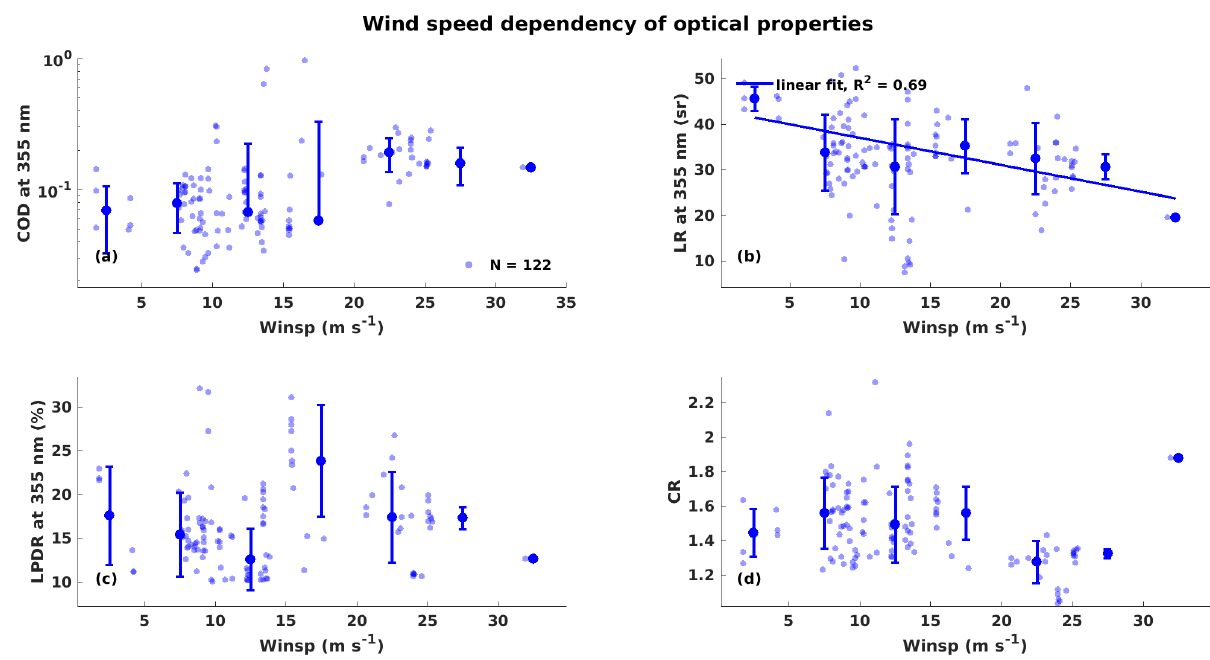
Figure 11. Same as Figure 10, except for dependence on wind speed (5 ms − 1 classes). Only observations satisfying the 2 h temporal criterion are